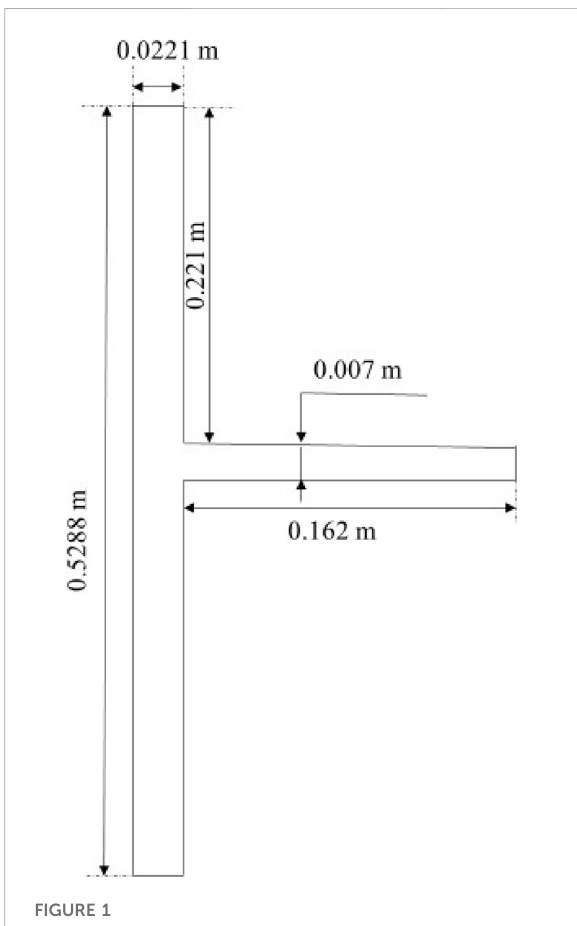
FIGURE 1 Schematic of the simulation domain of